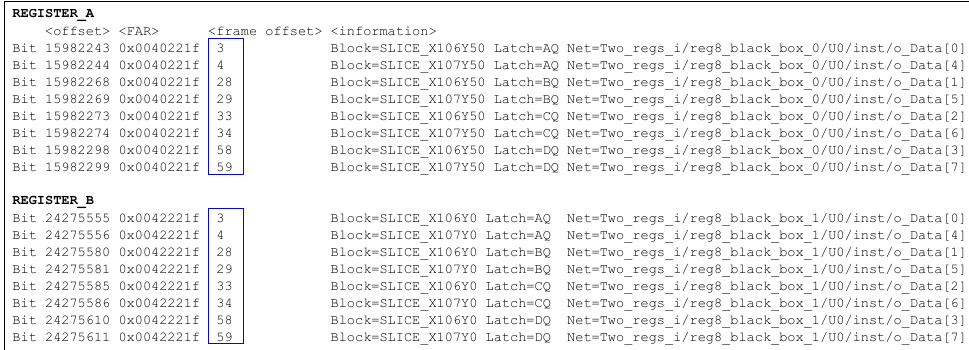
Figure 8. Device image of the design with placement constraints from Vivado.